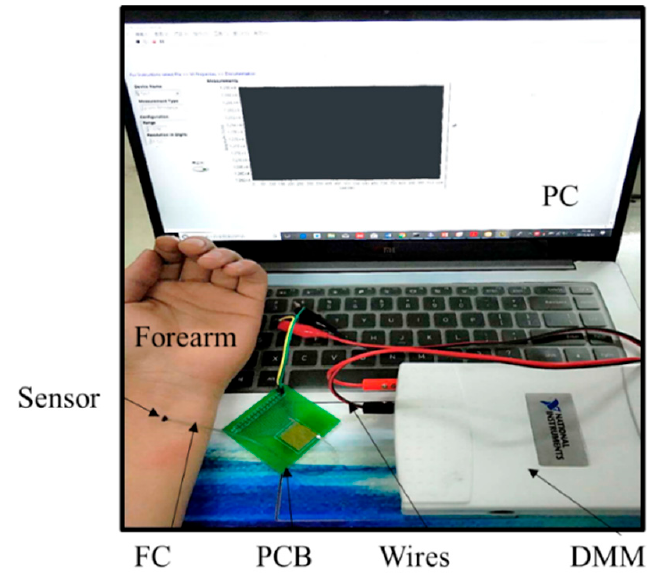
Figure 3. Image of the sensor measurement system.